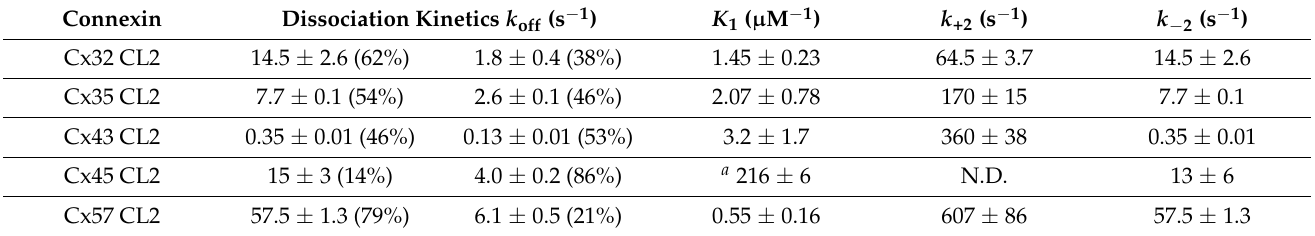
Table 3. Kinetic parameters of Ca 2+ /DA-CaM interaction with Cx CL2